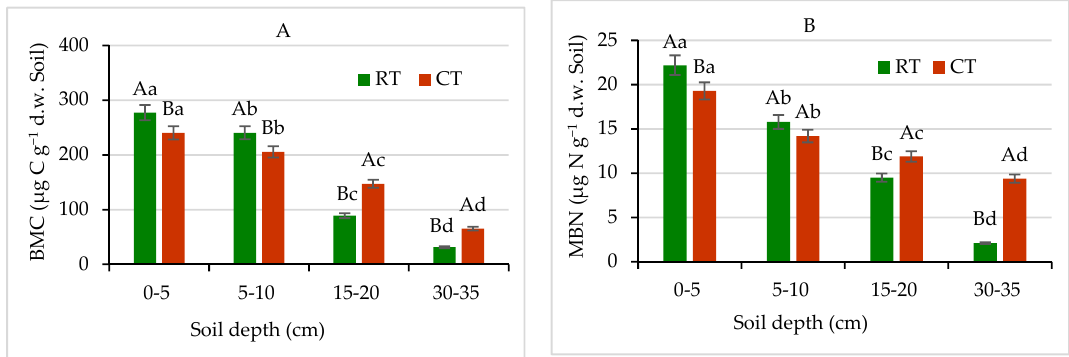
Figure 8. ( A ) Microbial biomass carbon (MBC) and ( B ) microbial biomass nitrogen (MBN) contents in soil under different tillage systems in 2018–2020 (expressed as means for the 3 years, n = 12). Different letters represent significant differences ( p ≤ 0.05) across treatments according to Tukey’s HSD test; lowercase letters within the same tillage system indicate significant differences between soil depths; uppercase letters indicate differences between tillage systems. RT—reduced tillage system; CT—conventional tillage system; d.w.—dry weight of soil; n —number of samples. Vertical bars represent standard errors.